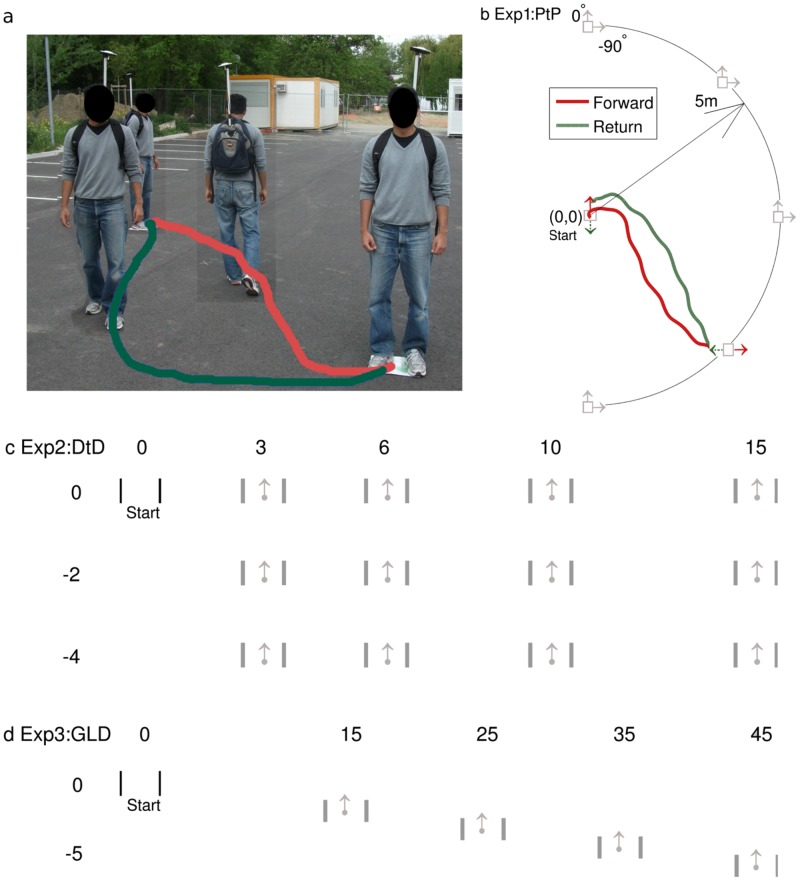
Experimental layouts.(A) Superimposed pictures illustrate the posture of the participants during the start, middle and end of the forward and return paths. (B) Exp 1, PtP—Fixed starting position (0,0), orientation (0°, straight ahead), and various goal positions and orientations are indicated by the squares and arrows. Sample forward (solid line) and return (dashed line) paths are shown for the (GA = −135°, GO = −90°) condition. (C) Exp 2, DtD—Start and goal positions were set in a rectangular grid. Note that participants started and stopped 2m before and after the doors. (D) Exp3, GLD—Goals were located at a fixed angle of −108° and at varying distances.